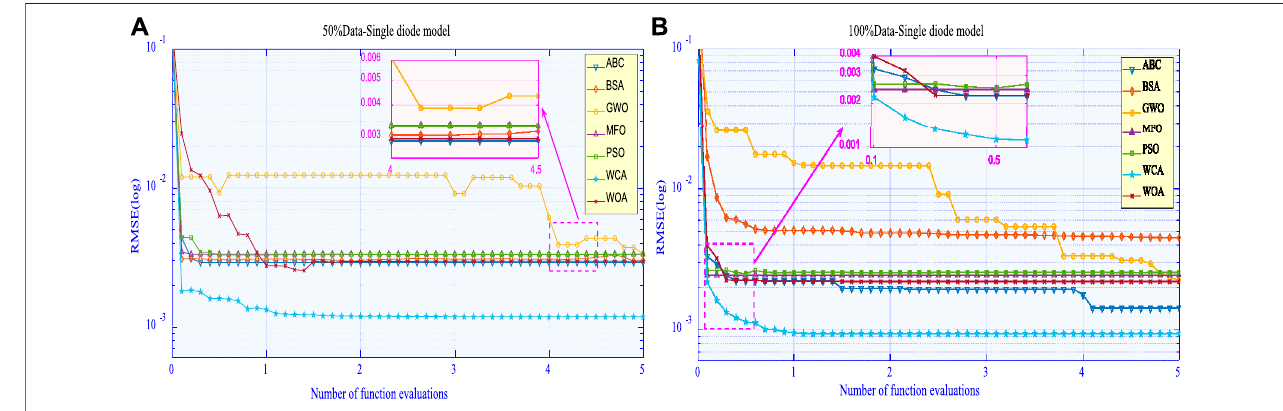
FIGURE 10 | Convergence of different algorithms for the DDM: (A) 50% data and (B) 100%